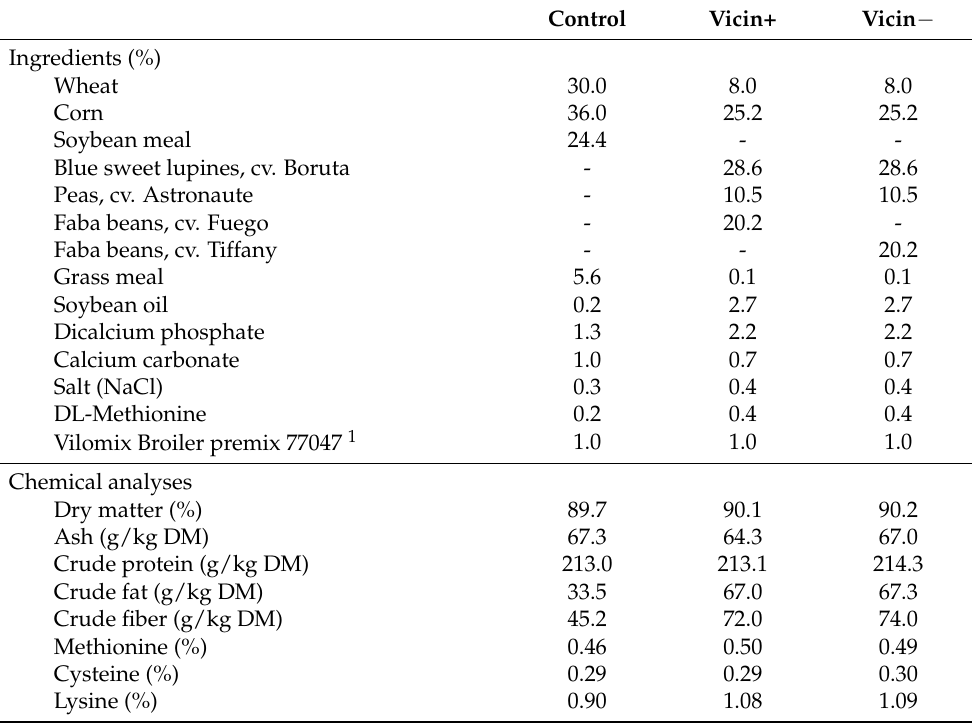
Table 1. Ingredient composition of each experimental diet.